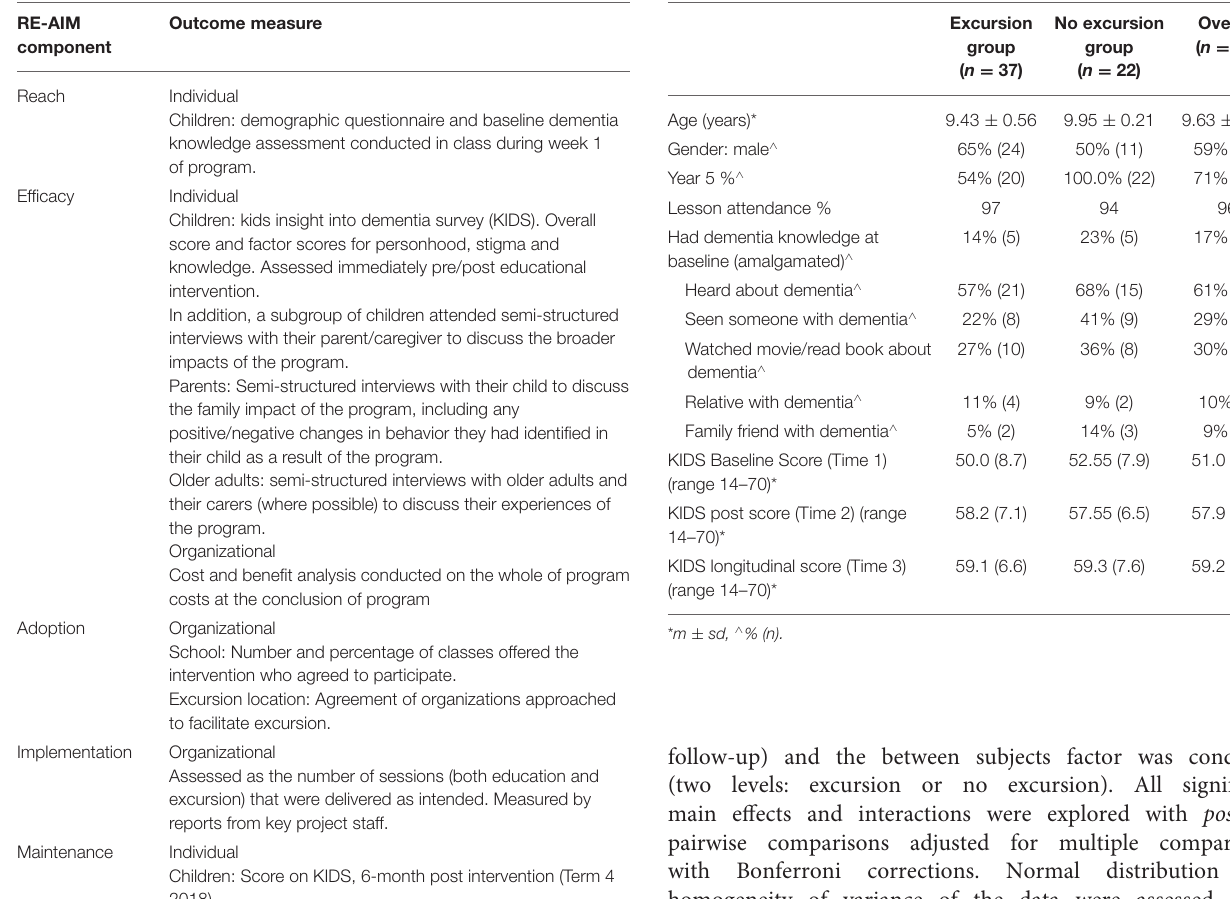
TABLE 3 | Demographic characteristics of students participating in the dementia education program.